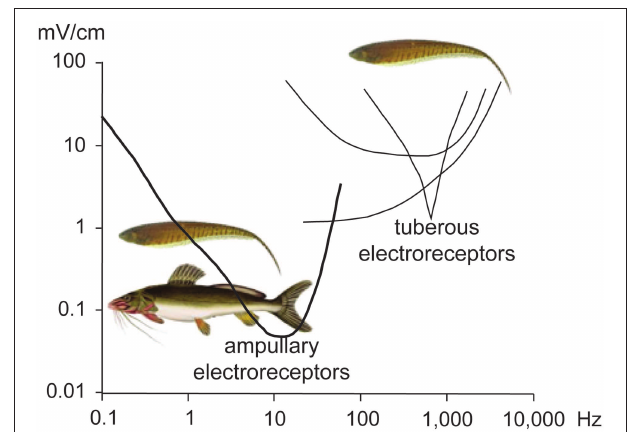
FIGURE 1 | Tuning curves of the two general types of electroreceptors. All electroreceptive fishes have some sort of ampullary electroreceptors, which are extremely sensitive to low-frequency electric fields. Gymnotiform and mormyrid electric fishes have also evolved tuberous electroreceptors which are less sensitive and tuned to higher frequencies to detect the fish’s own electric field and electric fields of nearby conspecifics. The ampullary receptor curve was recorded from a Gymnotus sp. (Dunning, 1973), and the tuberous receptor curves were recorded from Brachyhypopomus occidentalis ( Shumway and Zelick, 1988 ). Adapted from Stoddard (2002a) with permission of the